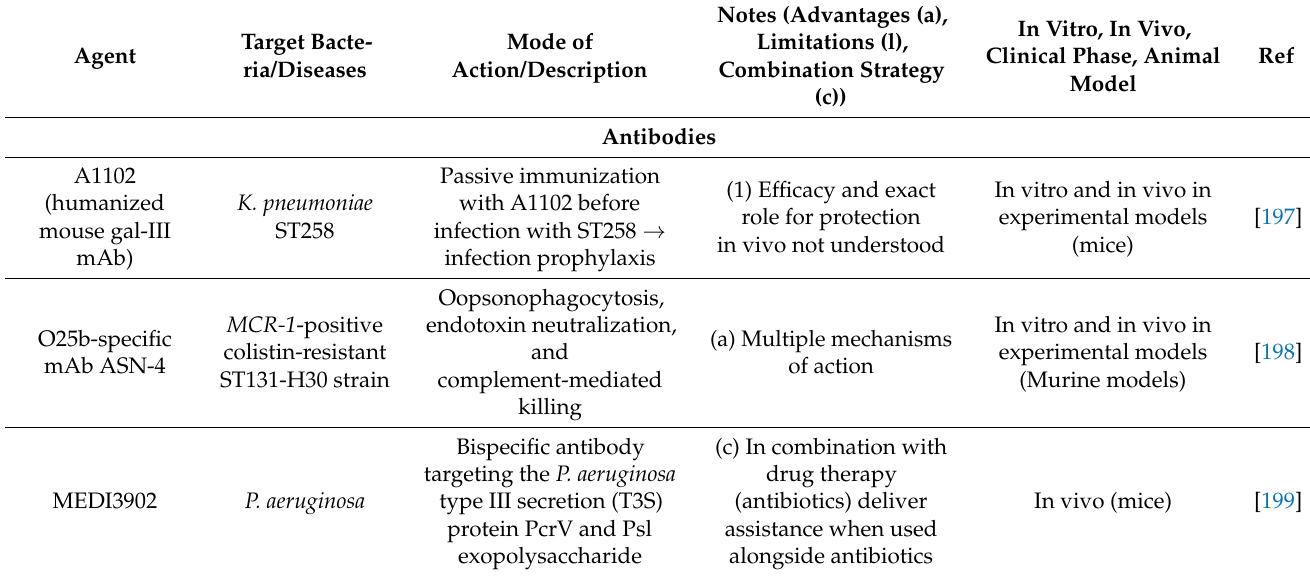
Table 7. Novel antibodies are used against bacteria with and/or without drug